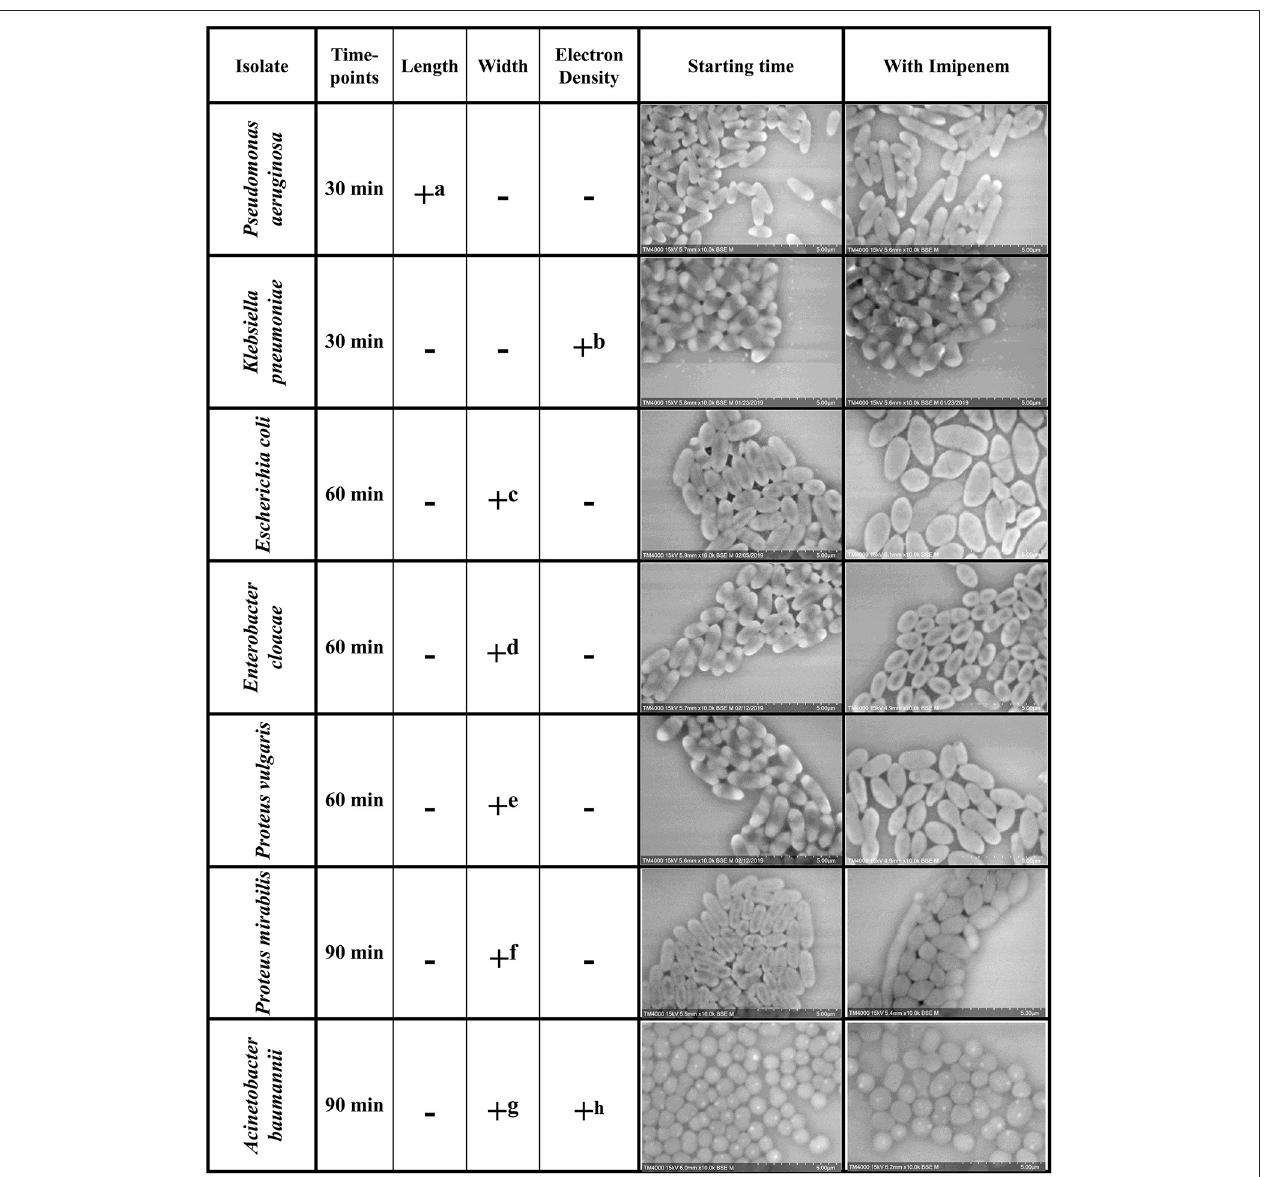
FIGURE 2 | Summary of the morphological modifications associated with susceptibility to IPM for each of the selected species. + : criteria detected; − : criteria not detected (a) Increase in P. aeruginosa bacterial lengths in the susceptible isolates after 30min of incubation with IPM. (b) Loss of the brightness signal at the extremities in K. pneumoniae susceptible isolates after 30min of incubation with IPM. (c-f) Increase in bacterial diameter; emergence of an ovoid shape in susceptible isolates after 60min of incubation with IPM. (g) Inflated A. baumannii greatly outnumbers regular sized ones compared to resistant isolates. (h) The number of A. baumannii showing hyperdense dots decreases in the susceptible isolates and increases in the resistant ones.